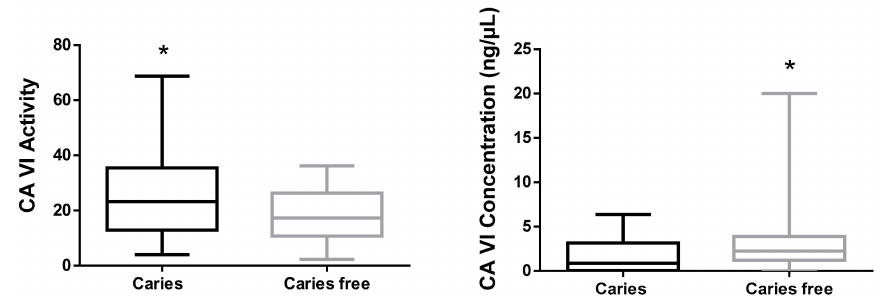
Figure 2. Boxplot graphics of CA VI activity (CA VI) ( p = 0.0421, Mann Whitney test) and of CA VI concentration ( p = 0.0335, Mann-Whitney test) in dental biofilm of caries and caries-free children. * Means statistically significant di ff erence between groups.